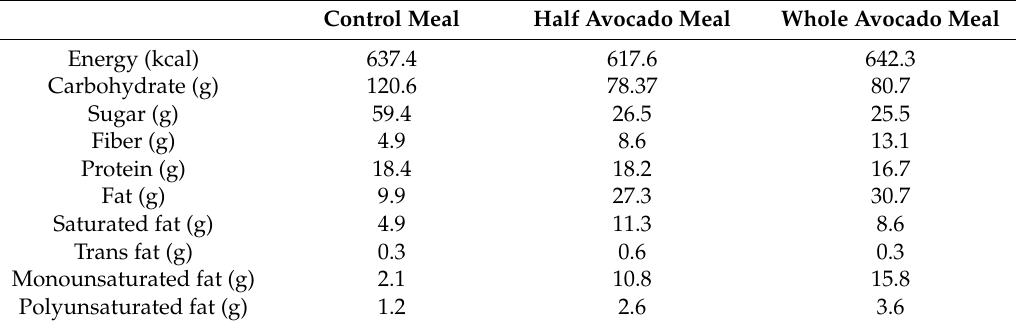
Table 1. Nutrient composition of breakfast meals for postprandial study visits *.